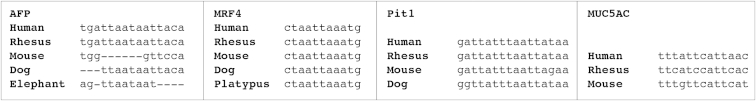
Conservation of ZFHX3 Binding Sites across Species, Related to Experimental ProceduresA multiple sequence alignment for ZFHX3 binding sites for Afp, Mrf4, Pit1, and Muc5ac reveals conservation of the motif across both primates and placental mammals.